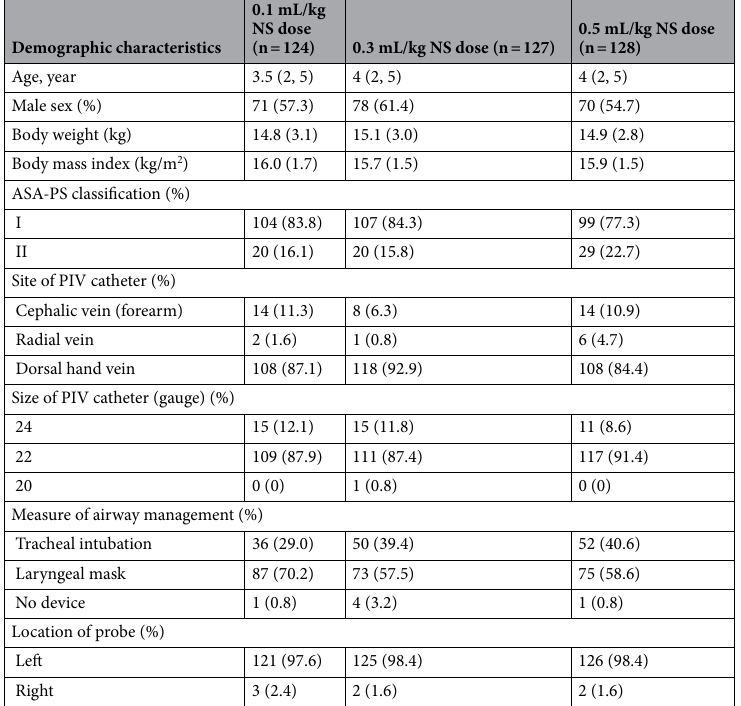
Comparison of the proportion of positive test results in the S-test and V-test for each NS dose. The proportions of positive results (as per rater 1) in the S-test and V-test for each of the three doses were statistically significant in all dose groups (0.1 mL/kg, 0.3 mL/kg, 0.5 mL/kg; all p < 0.001) (Fig. 2).